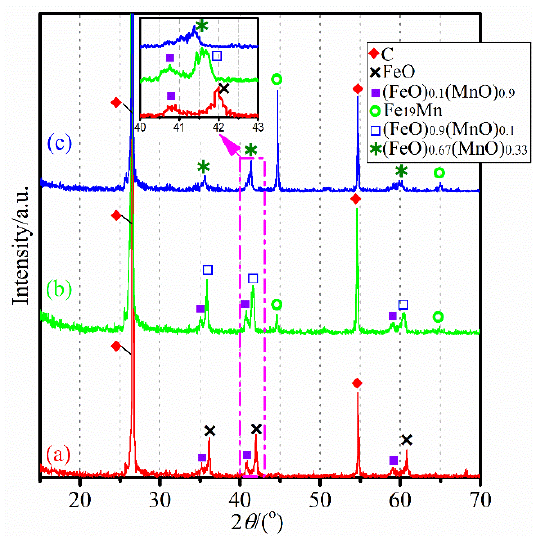
Figure 5. XRD patterns of the samples collected after reduction at 1000 °C for ( a ) 1 h, ( b ) 2 h, and ( c ) 4 h.